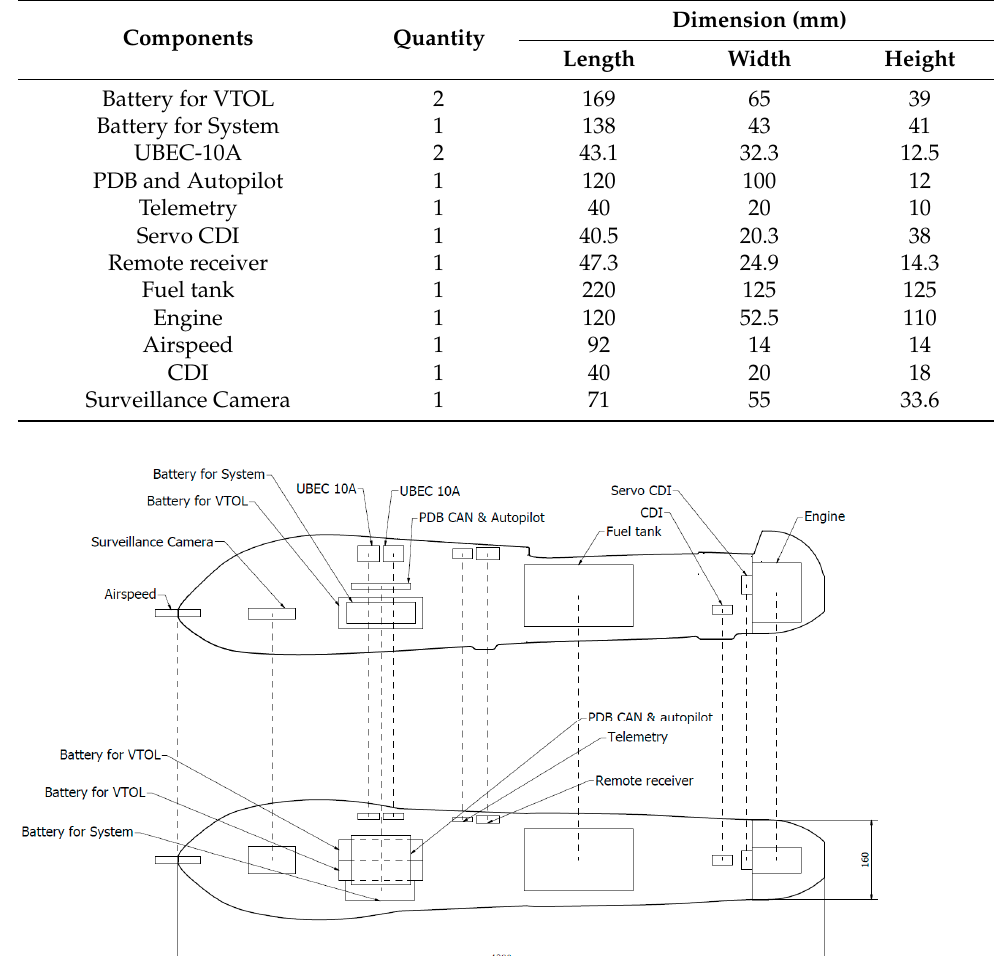
Table 6. Payload dimension on the fuselage.